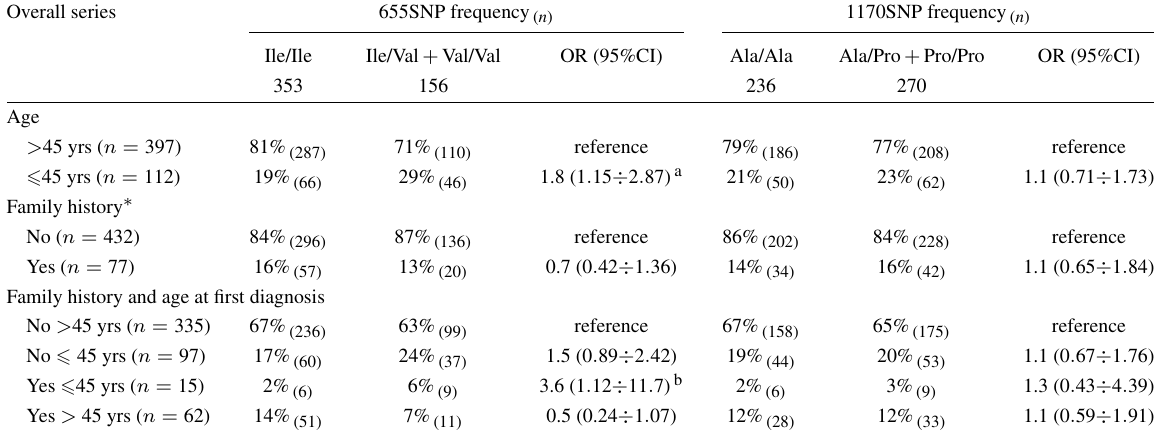
Breast cancer risk in individuals with a family history of the disease: age stratification